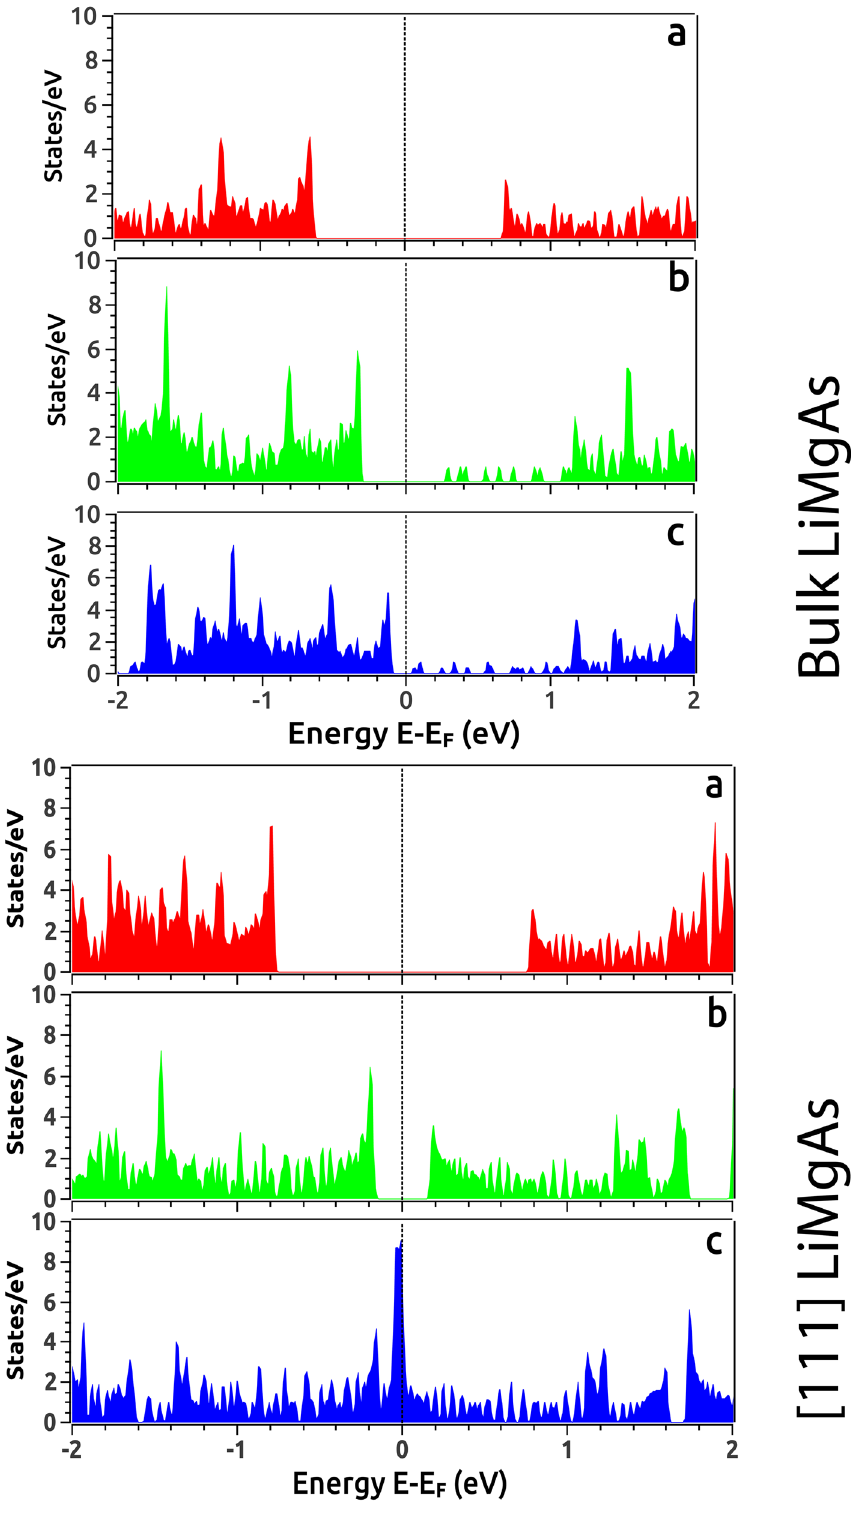
Figure 3. Density of States (DOS) for the bulk (top panel) and the low-dimensional [111] phase of LiMgAs (bottom panel) at ( a − 0%, b − 8%, c − 15%) and ( a − 0%, b − 8%, c − 10%) pressures